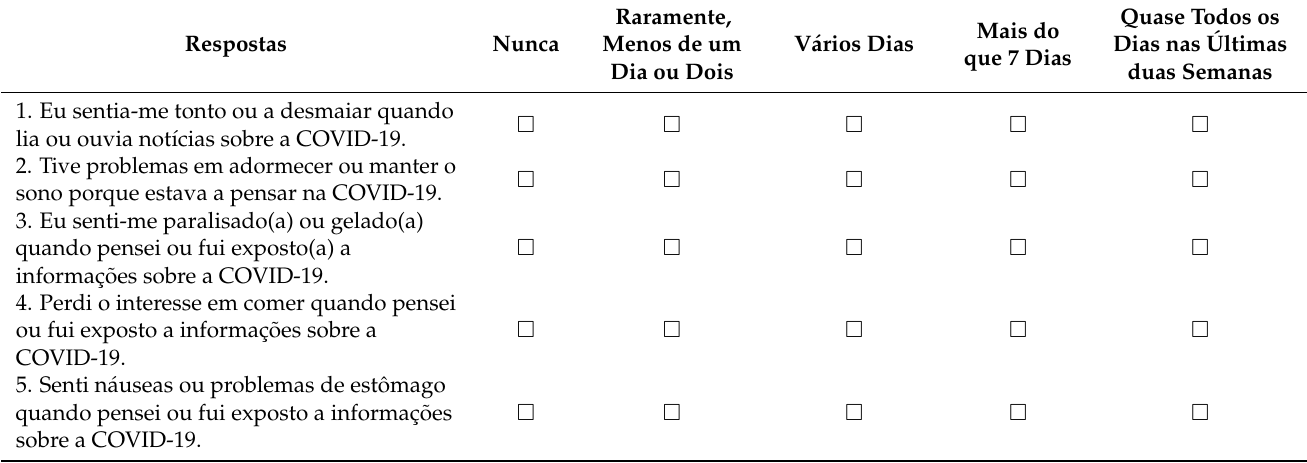
Table A4. Items of the Coronavirus Anxiety Scale (Portuguese